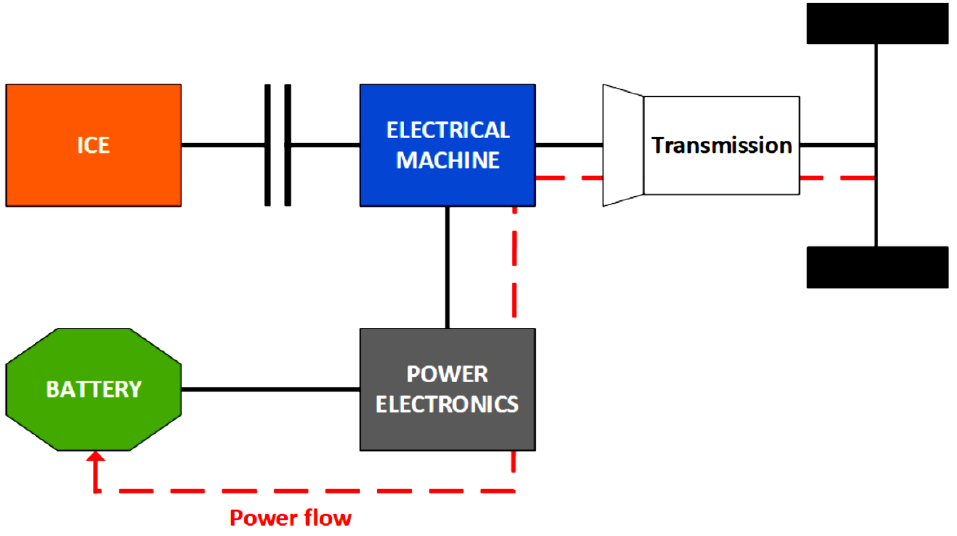
Figure 2. Hybrid vehicle power flow in recuperation mode [10].